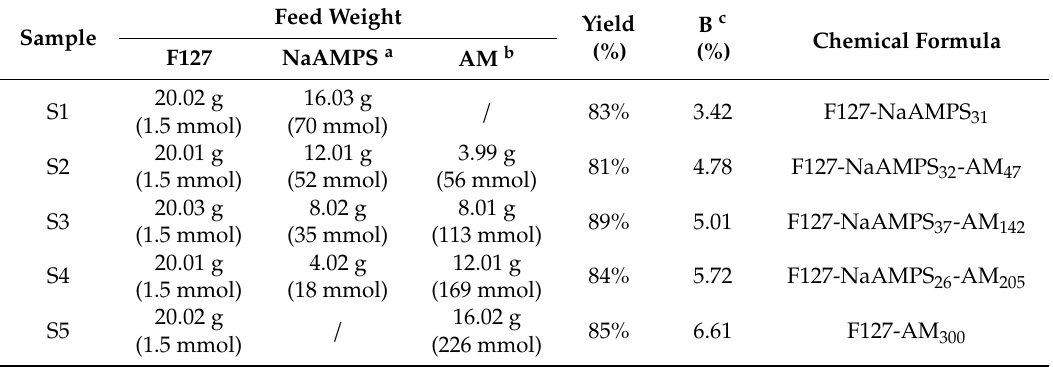
Table 1. Feed weight, yield and chemical formula of the five prepared polymers. Sample